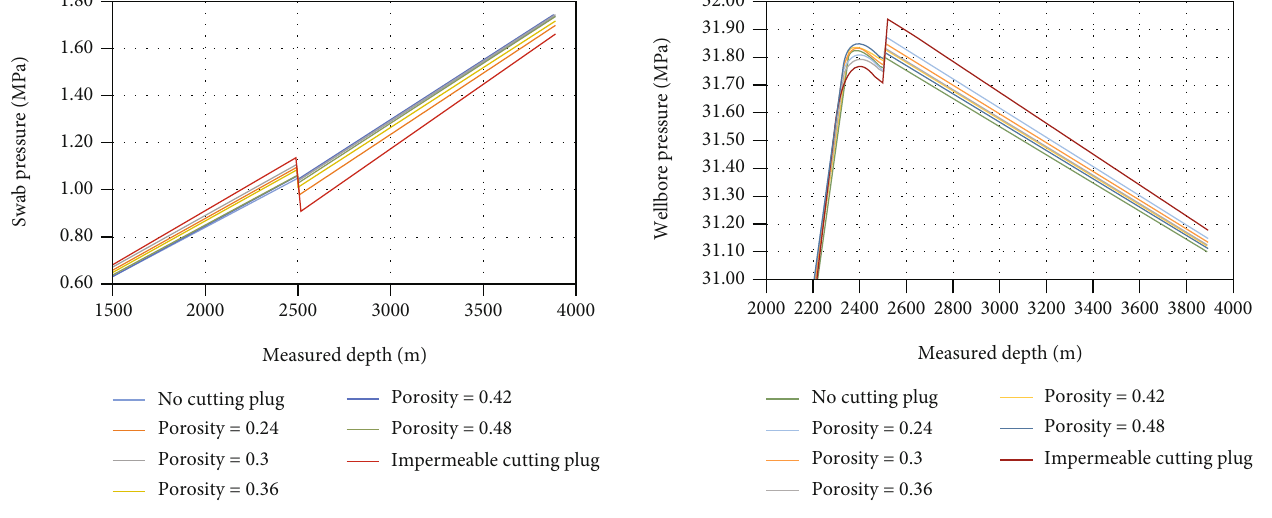
Figure 11: The e ff ect of cutting plug porosity on the swab pressures in an open pipe condition.